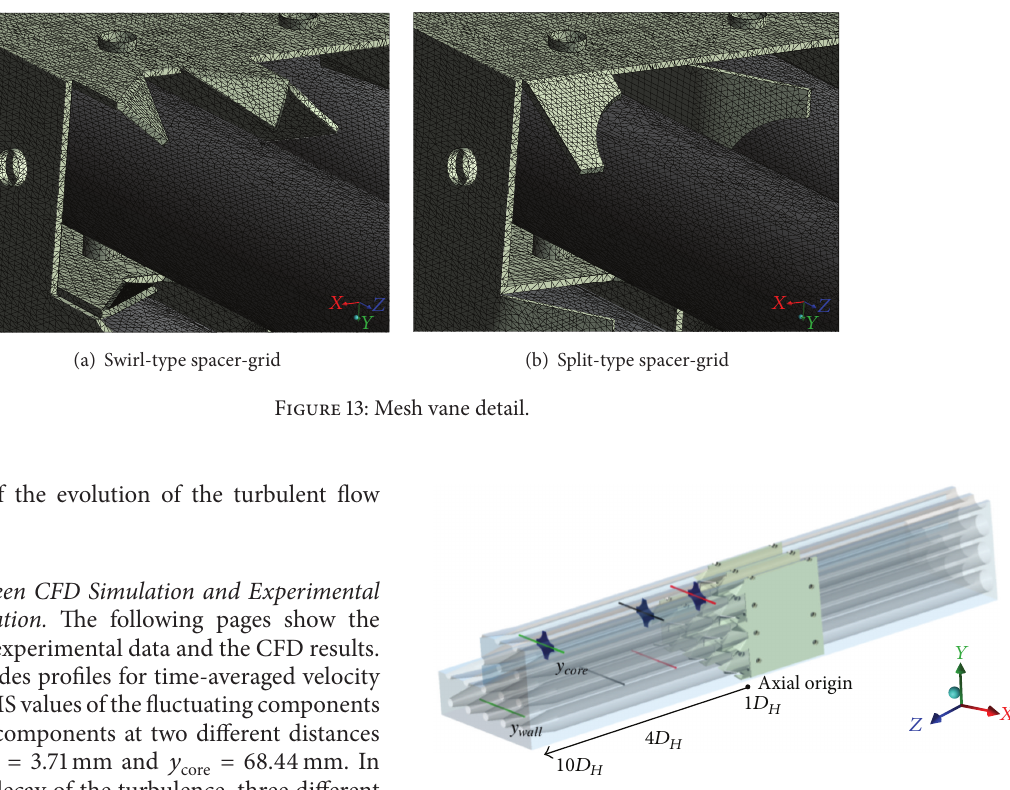
Figure 14: Subchannel and measurement lines at different axial positions from the specified origin coordinate